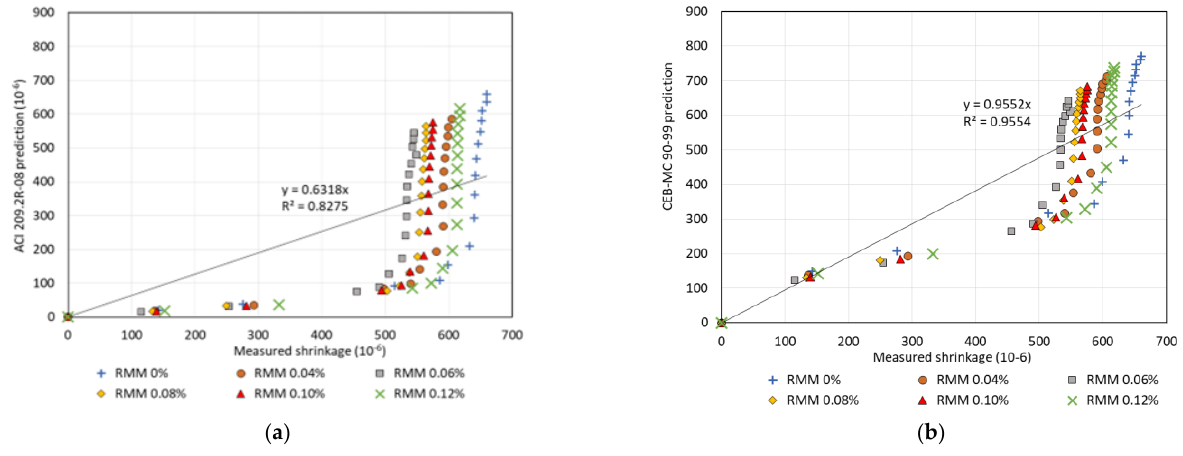
Figure 7. Evaluation of the ACI 209.2R-08 ( a ) and CEB-MC 90-99 ( b ) models by best fit line method.